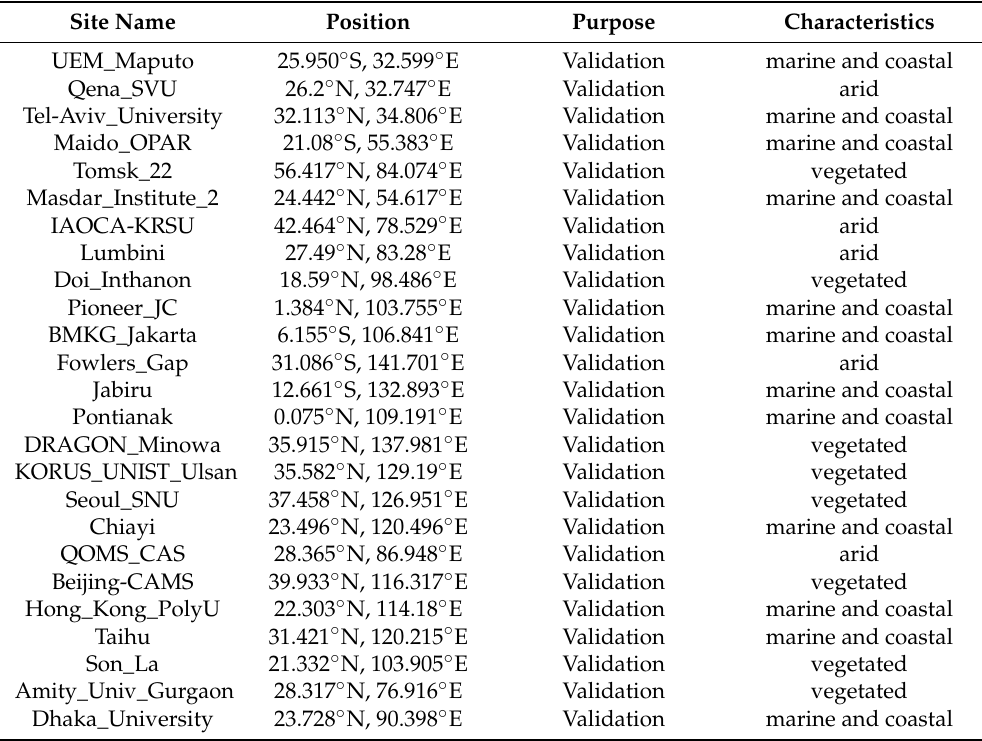
Table 2. AERONET sites used to verify the NNAeroG only for validation which were not used for